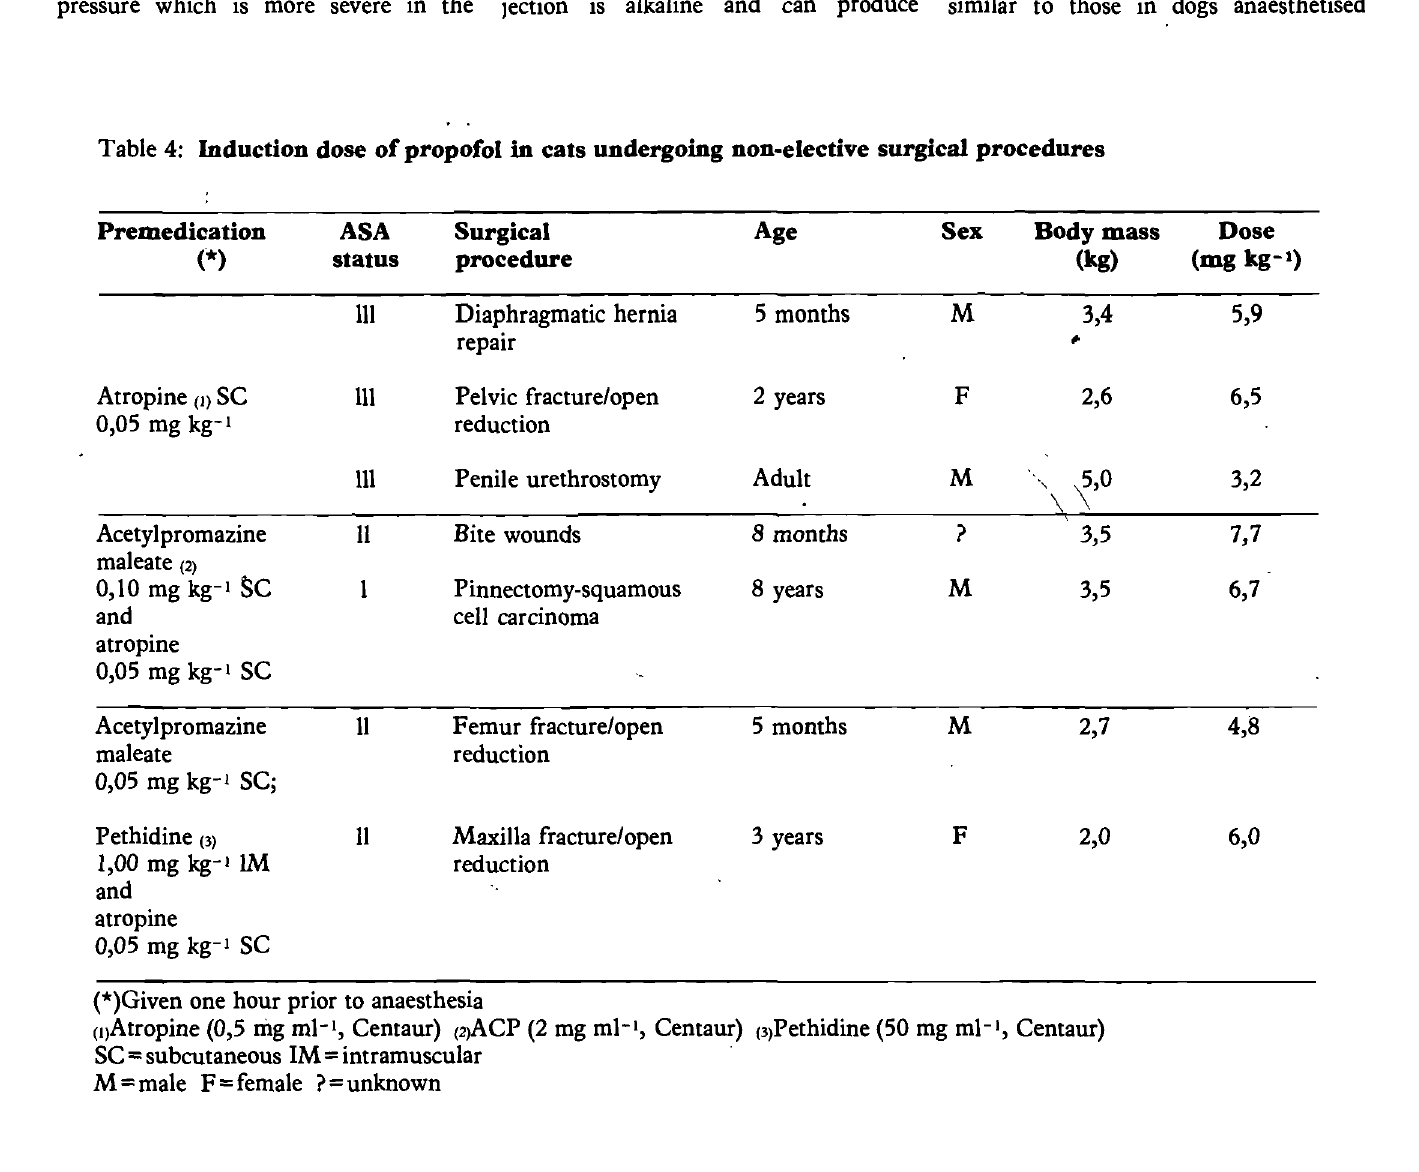
Table 4: Induction dose of propofol in cats undergoing non-elective surgical procedures